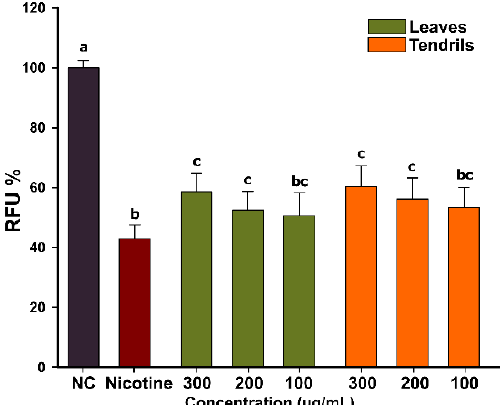
Figure 2. Cytoprotective e ff ect of LE and TE against nicotine-induced cytotoxicity was analyzed after a 24 h post-exposure to three concentrations of the LE and TE in combination with 10 µ M nicotine using AB assay. The values are expressed as mean ± standard deviation (SD) of three biological replicates. Di ff erent letters (a–c) represent the significant di ff erences in mean cellular viability (ANOVA + Holm-Sidak post hoc test at p < 0.05 level of significance).